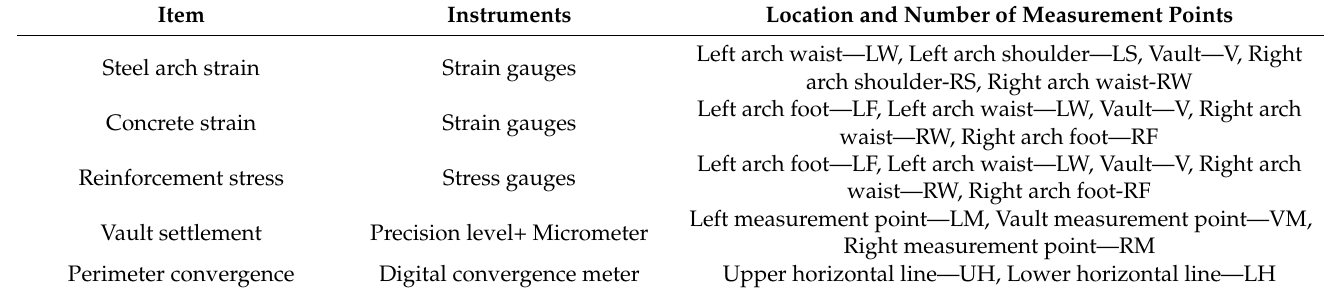
Table 3. List of monitoring contents and location of measurement points.